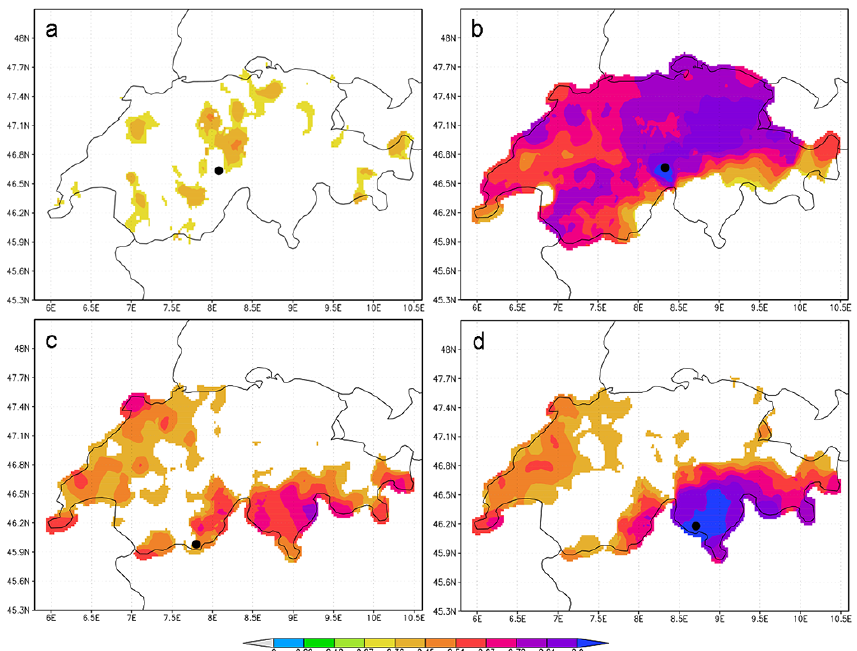
Figure 10. Spatial correlation map of annual records with the Meteoswiss gridded precipitation for northern Alpine (upper panels, period 1961–2001) and southern Alpine sites (lower panels, period 1961–1993, 1968–1970 excluded). Correlation with (a) Fiescherhorn annual net accumulation (where an offset of − 1year was introduced), (b) Grimsel Hospiz annual precipitation, (c) Grenzgletscher annual net accumulation, (d) Locarno annual precipitation. Black dots indicate the location of the sites. Areas with correlation coefficients statistically significant at the 5% level are